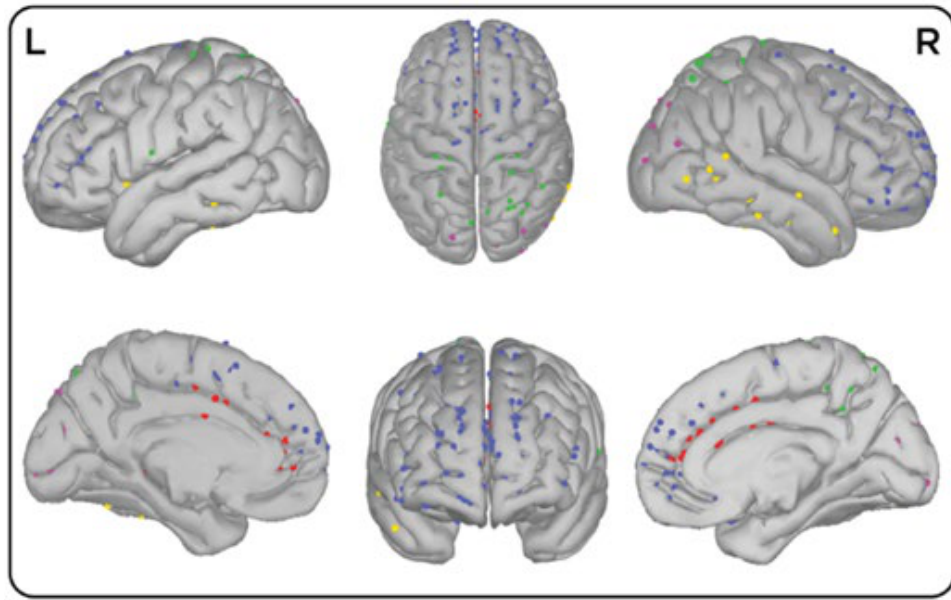
Figure 1. Illustration of the sources of spikes, blue: frontal lobe, red: limbic lobe, yellow: temporal lobe, green: parietal lobe, fuchsia: occipital lobe.